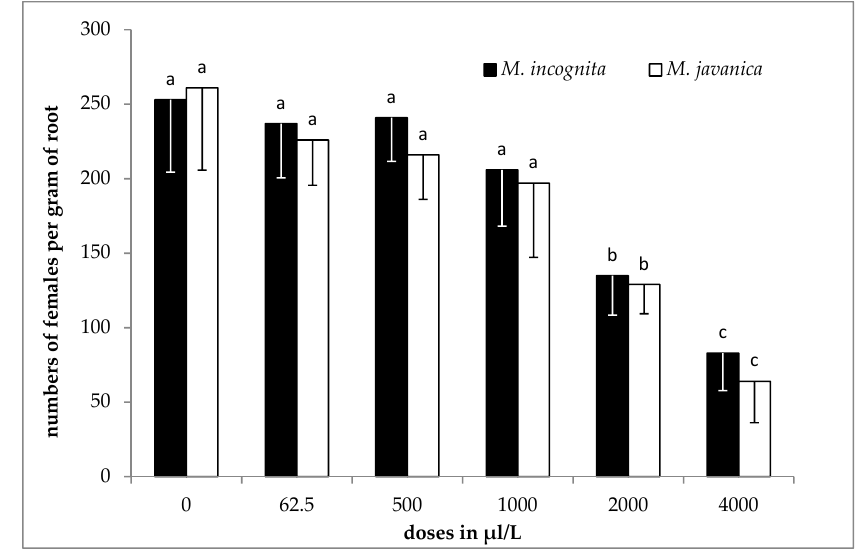
Figure 5. Numbers of females of M. javanica and M. incognita per gram of root, after transplanting tomato seedlings in soil treated with essential oil of Satureja hellenica and inoculating with 600 J2s. Bars with the same color followed by the same letter are not significantly di ff erent. Error bars represent the standard deviation of